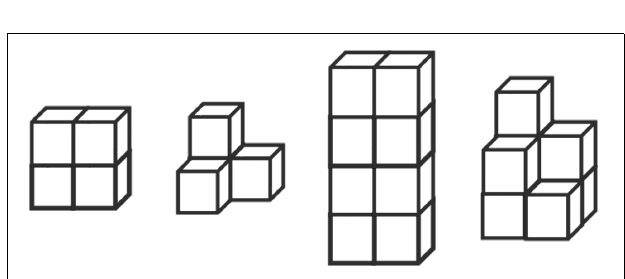
FIGURE 4 | The cube transformation